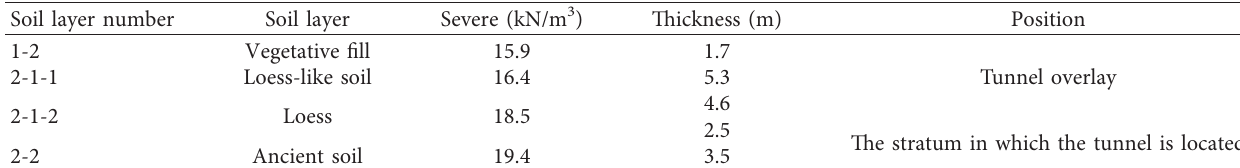
Table 1: Soil parameters.